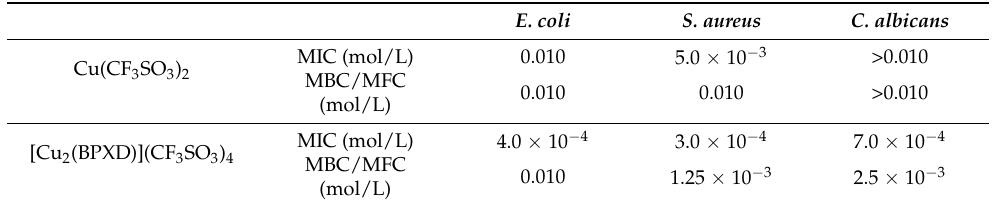
Table 2. MIC and MBC/MFC values obtained for [Cu 2 (BPXD)](CF 3 SO 3 ) 4 complex compared with values obtained with Cu(CF 3 SO 3 ) 2 salt.